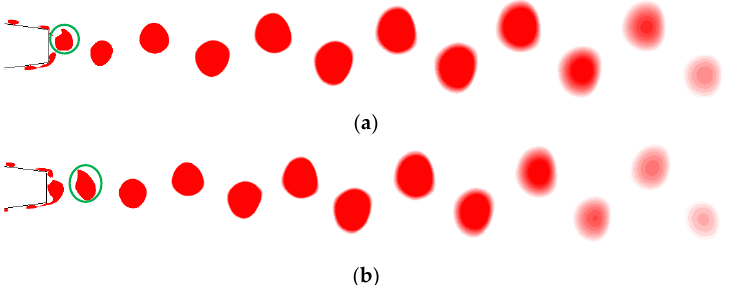
Figure 14. Contour plots of the Eulerian Q criterion in the range from 1,000,000 to 3,000,000 s −2 for no cavitation, 𝜎𝜎 𝑖𝑖 = 2 𝜎𝜎 𝑖𝑖 = 0.69